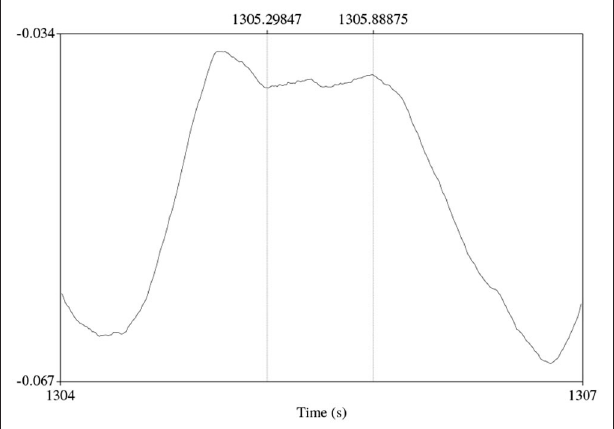
FIGURE 8 | An abandoned initiation candidate: a silent cycle with a respiratory hold (indicated by vertical lines) in the top part of the exhalatory phase.